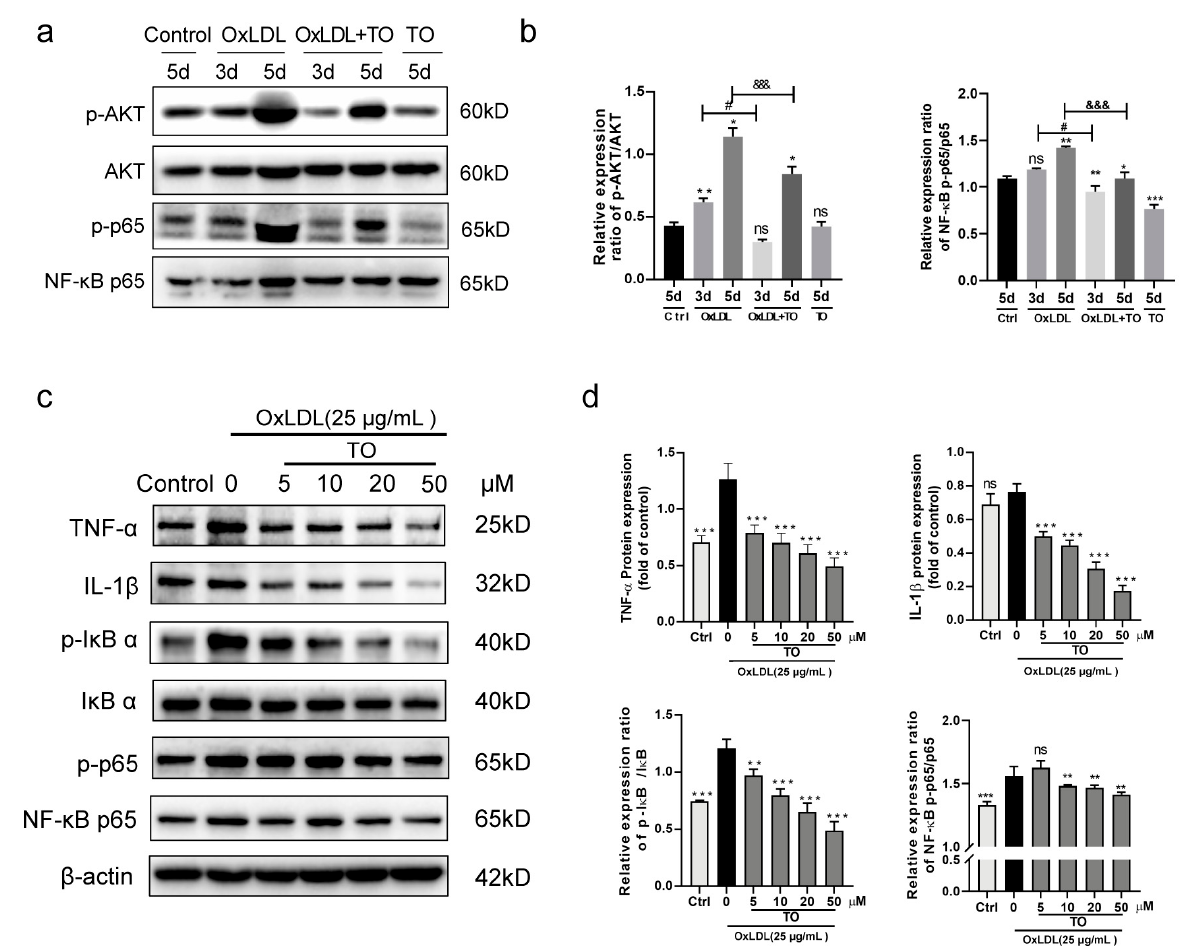
Figure 4. LXR agonists Inhibits OxLDL ‐ activated the AKT and NF ‐κ B pathway. ( a ) Using Western blotting, the presence of AKT and the NF ‐κ B route in choroidal tissues of mice was determined. ( b ) Quantification of AKT and NF ‐κ B pathway protein expression. n=3, ns indicates p > 0.05, * p < 0.05, ** p < 0.01, *** p < 0.001 vs. 5 d control group, # p < 0.05 vs. 3 d OxLDL group, &&& p < 0.001 vs. 5 d OxLDL group ( c ) Western blotting was employed to detect the manifestation of NF ‐κ B route in model RPE cell. ( d ) Quantification of TNF ‐α , IL ‐ 1 β , and NF ‐κ B pathway protein expression. Data are expressed as mean ± SEM, n = 3, ns means p > 0.05, * p < 0.05, ** p < 0.01, and *** p < 0.001 vs. OxLDL 25 μ g/mL group.